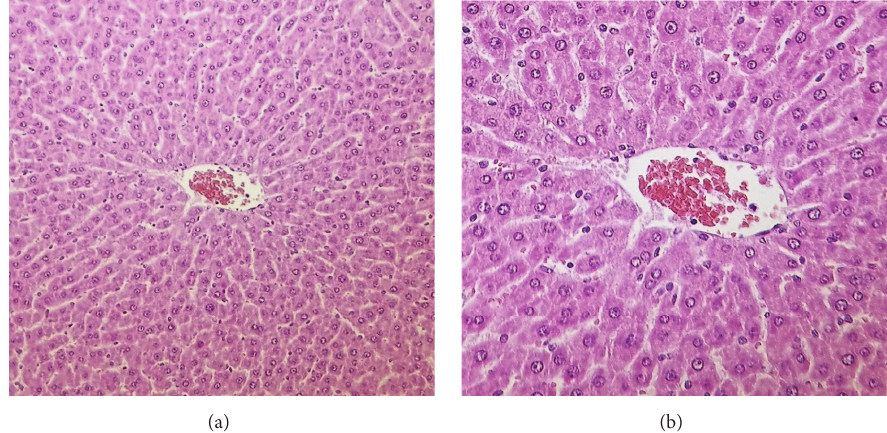
Figure 1: Intact (normal) hepatocytes around the central vein of a female rat at 375 mg/kgbw/day at terminal sacrifice. Haematoxylin and eosin staining; magnification 200x (a) and 400x (b).